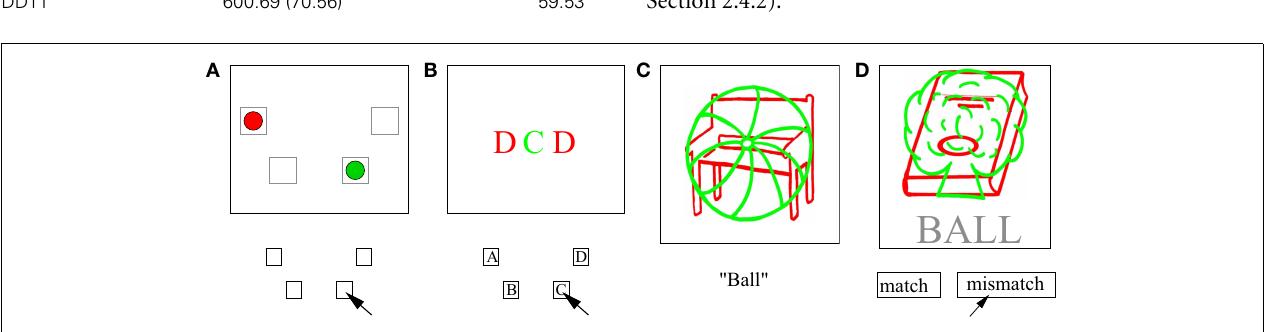
voicekey paradigm. (D) The word-picture comparison paradigm has the advantage of a disentanglement of target identity and response.The examples have been adapted such that green always defines the